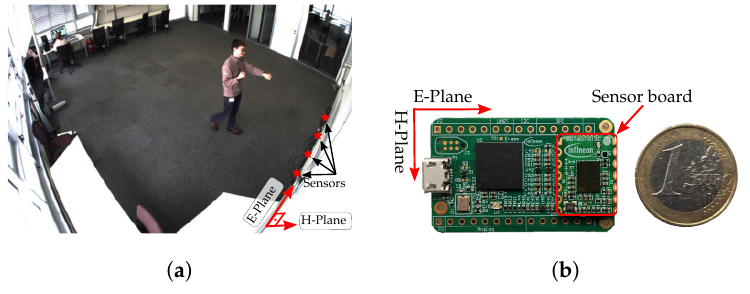
Figure 1. Experimental setup. ( a ) Overview of the measuring room. ( b ) Detail of the BGT60TR13C 60 GHz radar